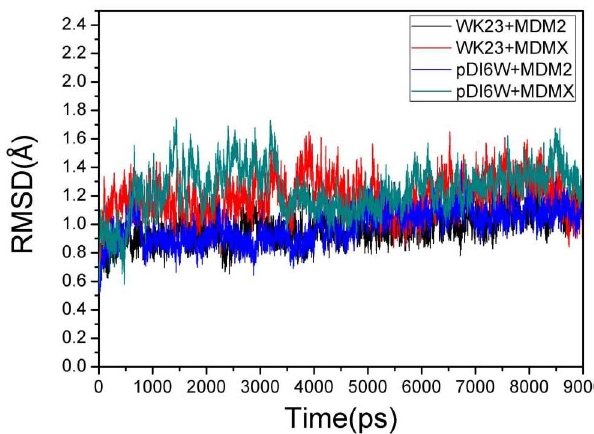
Figure 3. Root-mean-square deviations (RMSD) of backbone atoms relative to their initial minimized structures as function of time.